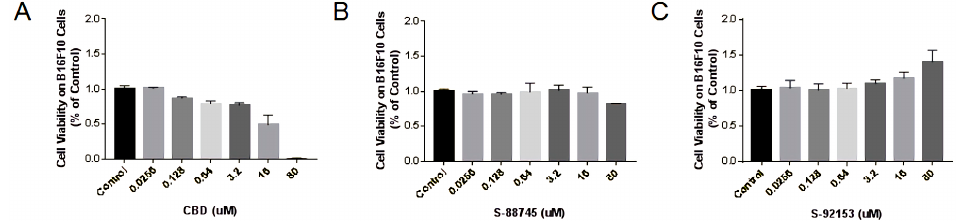
Figure 15. Cytotoxicity of ( A ) CBD and its derivatives, ( B ) S-88745 and ( C ) S-92153, on B16F10 cells. B16F10 cells were treated with cannabidiol, S-88745 or S-92153 for 72 h, and MTT assay was carried to detect the cell viability. The control group was not treated with CBD, S-88745 and S-92153. The experiments were repeated three times. Each bar illustrates the average ± standard deviation (SD) counted from three experiments.